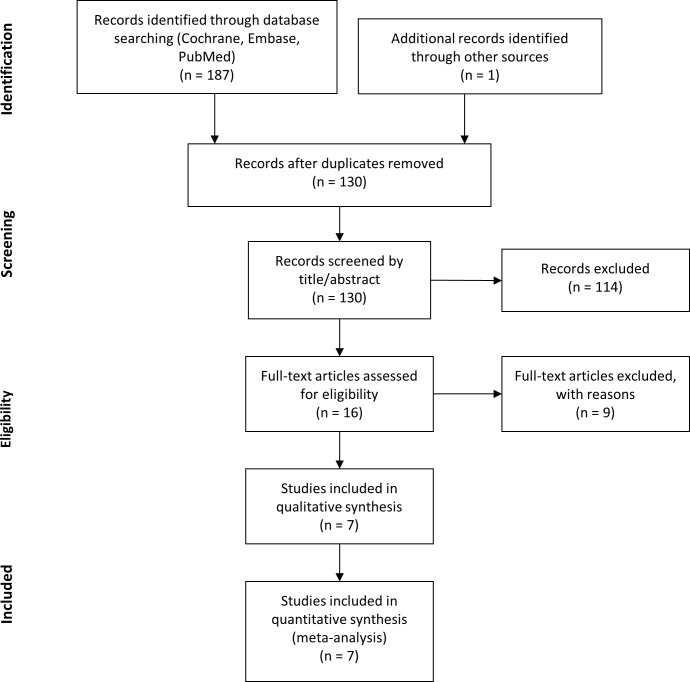
PRISMA flow diagram of study selection process.